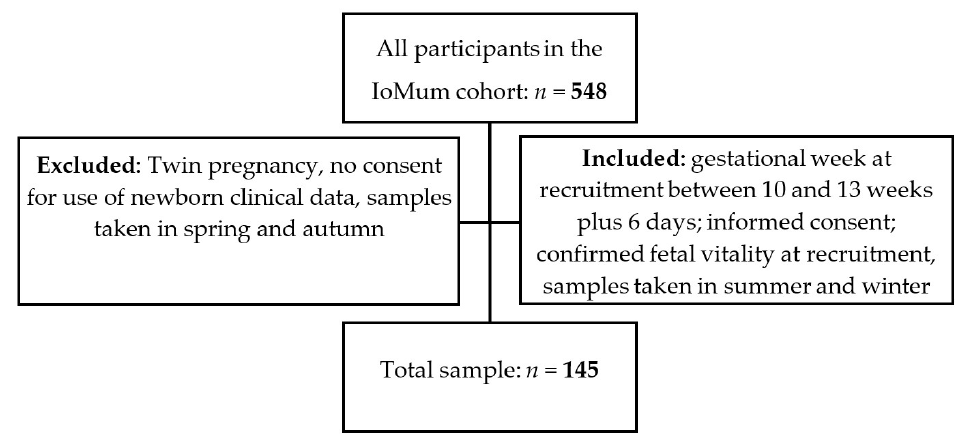
Figure 1. Recruitment and inclusion flowchart of the study.